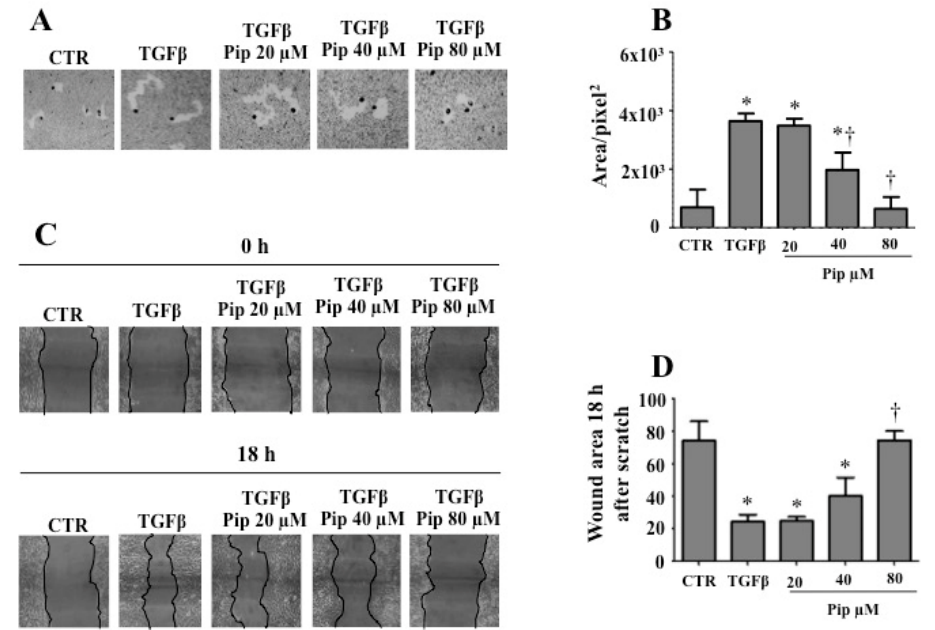
Figure 5. Pretreatment with piperine inhibits the cell motility of A549 cells treated with TGF- β 1. To analyze the cell motility, A549 cells were pretreated with non-cytotoxic doses of piperine (20, 40 and 80 µ M) for 24 h, followed by treatment with 1 ng / mL TGF- β 1 for 48 h. After treatments, the cell motility was evaluated based on phagokinetic motility ( A , B ) and wound assay ( C , D ). For phagokinetic motility, track area of 200 cells was monitored with the aid of the program Scion Image and expressed as squared pixels. For wound assay, photos were taken before and after incubation. The results are representative of four independent experiments. Quantitative analyses are shown as mean ± SD. * p ≤ 0.05 vs. untreated cells (CTR), † p ≤ 0.05 vs. TGF- β .